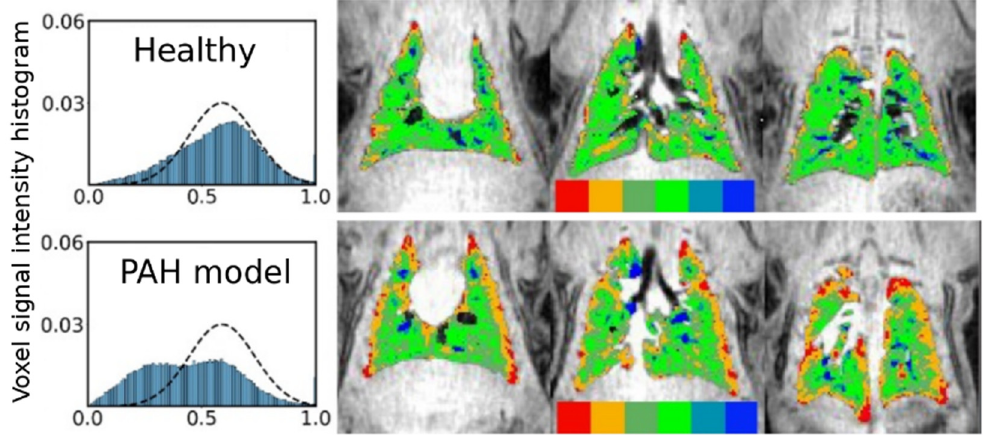
Figure 2. HXe images in a healthy rat (top) and pulmonary arterial hypertension model (bottom) show distinct patterns of reduced ventilation in the disease model (yellow and red partial and full detects). Note that interpretation of reduced signal as hypoventilation requires careful calibration of signal levels between subjects and accounting for partial volume effects during imaging. Reproduced with permission from Virgincar, 2018 (ref. [19]).